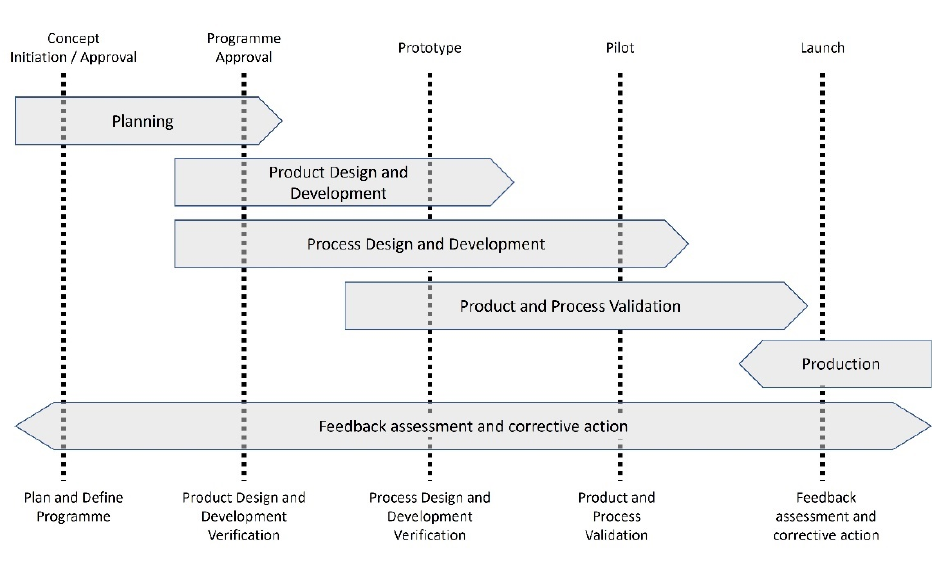
Figure 4. APQP phases for quality planning